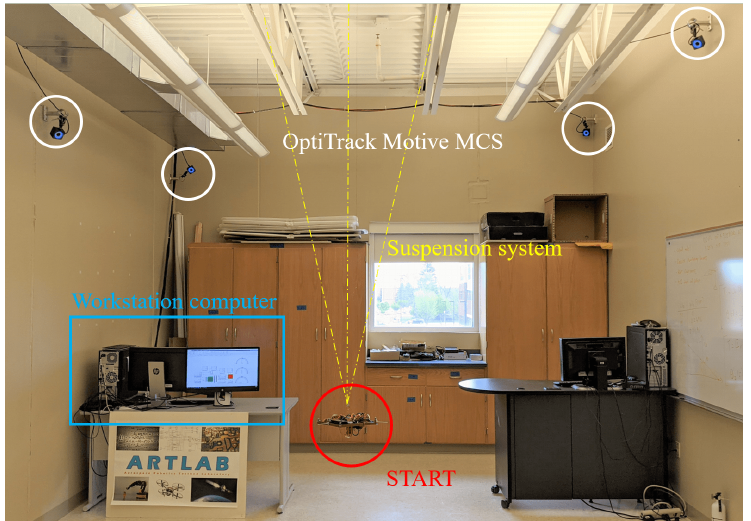
Figure 3. Picture of START in the Aerospace Robotics Testbed Laboratory